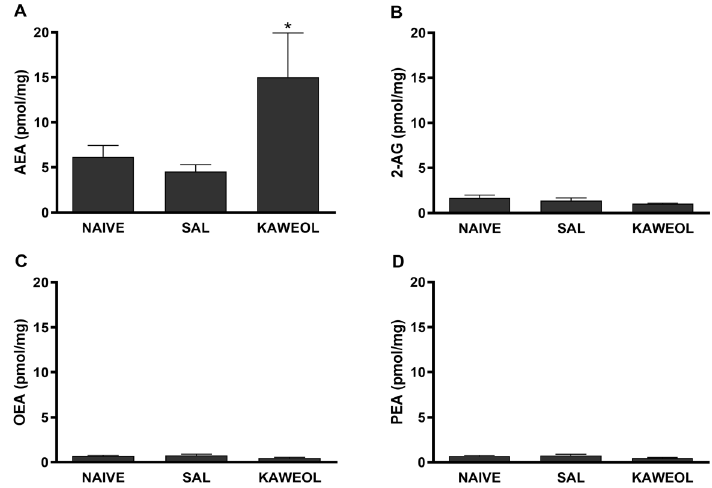
Figure 6. Increase of anandamide (AEA) levels ( A ), but not 2-arachidonoylglycerol (2-AG) ( B ), oleoylethanolamide (OEA) ( C ), and palmitoylethanolamide (PEA) ( D ) on kahweol injection. Kahweol (Kah; 80 m g/paw) was injected into the paw and 5 min later the paw tissues were collected for analysis. Data are reported as means ± SE (n=5). *P o 0.05 compared to Naive- and Saline (SAL)-injected groups (ANOVA and Bonferroni ’ s